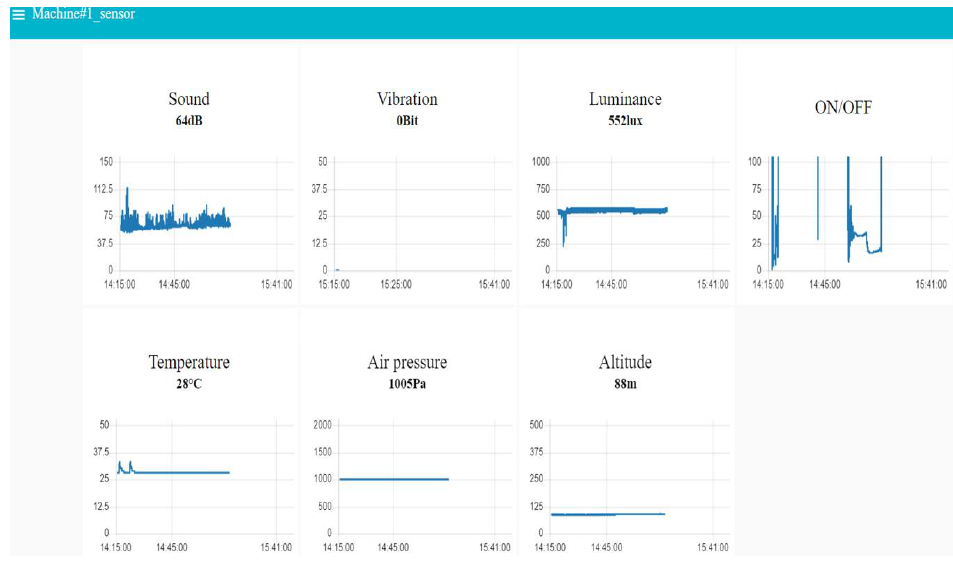
Figure 15. Real-time displays of sensor dashboards on the website.